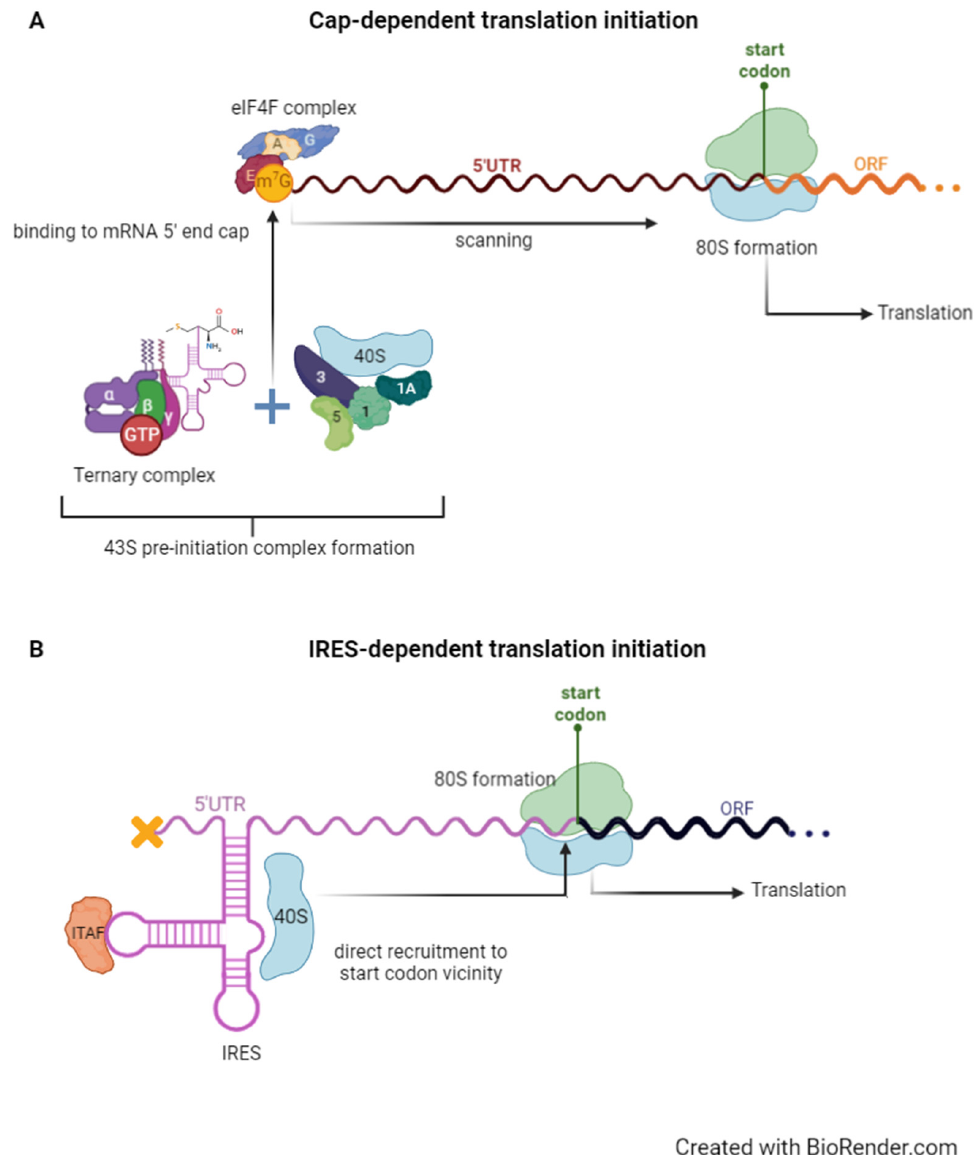
Figure 1. Cap-dependent versus internal ribosome entry site (IRES)-dependent translation initia- tion. ( A ): Canonical 5 ′ cap-dependent translation initiation. The canonical eukaryotic translation in-